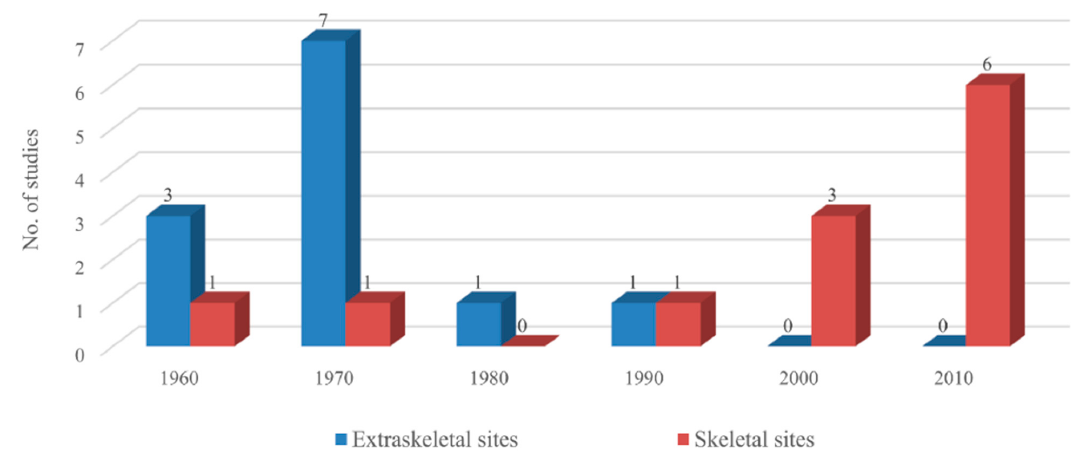
Figure 2. Total number of animal studies on allogeneic dentin grafts across decades. Preclinical in vivo studies on the implantation of allogeneic dentin grafts at the extraskeletal sites began in the 1960s along with the development of bone induction principle (BIP) [21,22], peaked in the 1970s, and then decreased until the 1990s. Since the 2000s, the number of in vivo studies on allogeneic dentin grafts at skeletal sites has begun to increase abruptly.